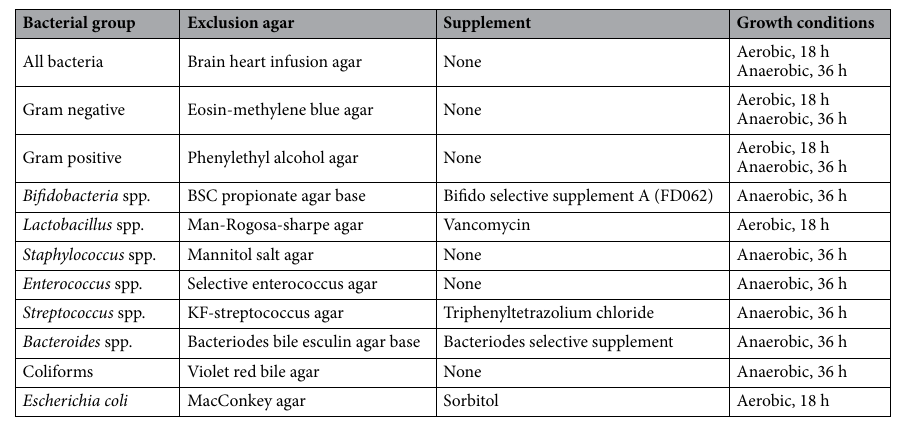
Table 1. Selective agar composition for viable plate